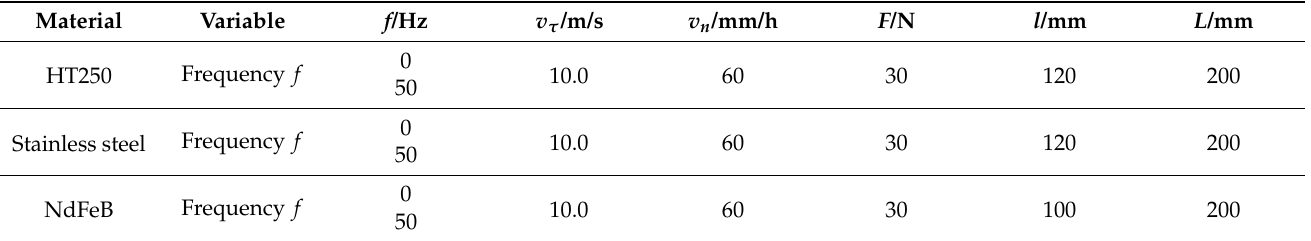
Table 3. Experimental design of surface